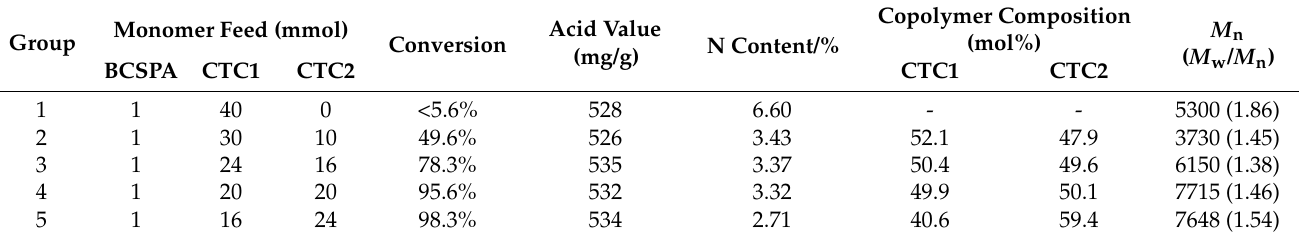
Table 1. Copolymer composition at various CTC